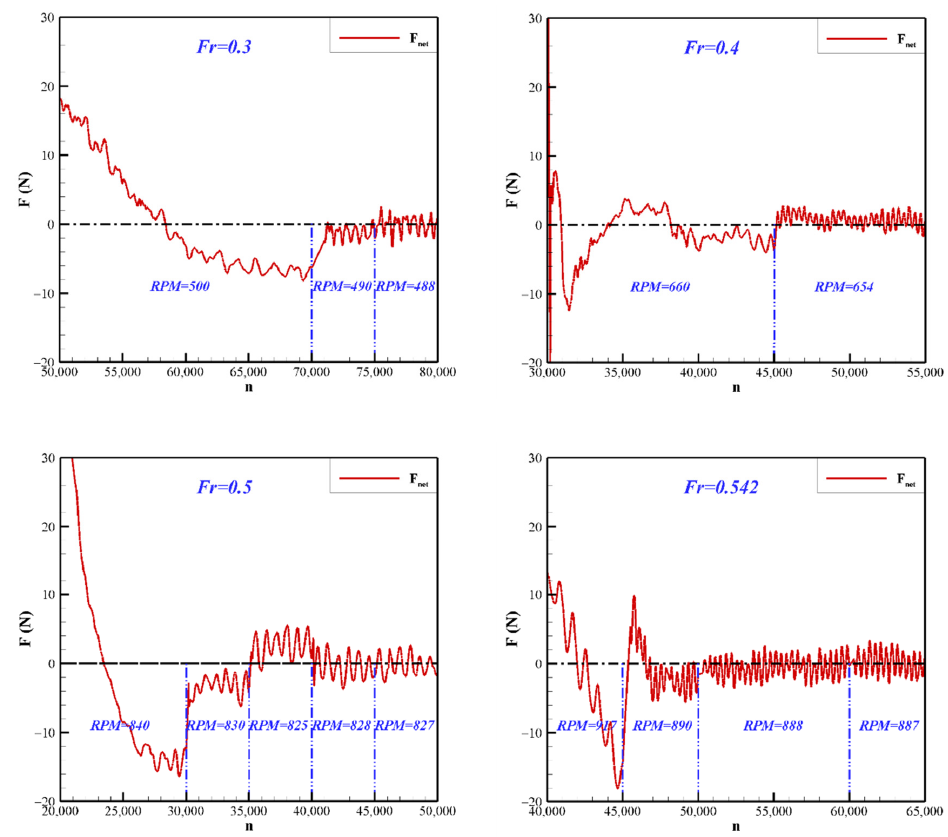
Figure 9. Convergence history of the net force F net of waterjet-propelled ship with the MRF model.